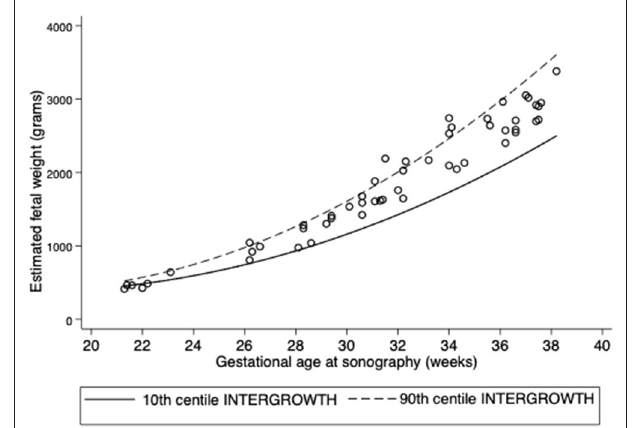
FIGURE 1 | Scatter plots of symphysis-fundal height (cm). Lines correspond to the 10 and 90th centiles according to INTERGROWTH standards.